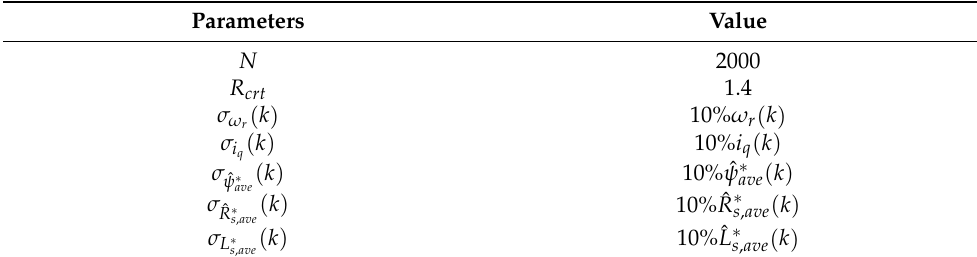
Table 2. Parameters of the proposed algorithm.